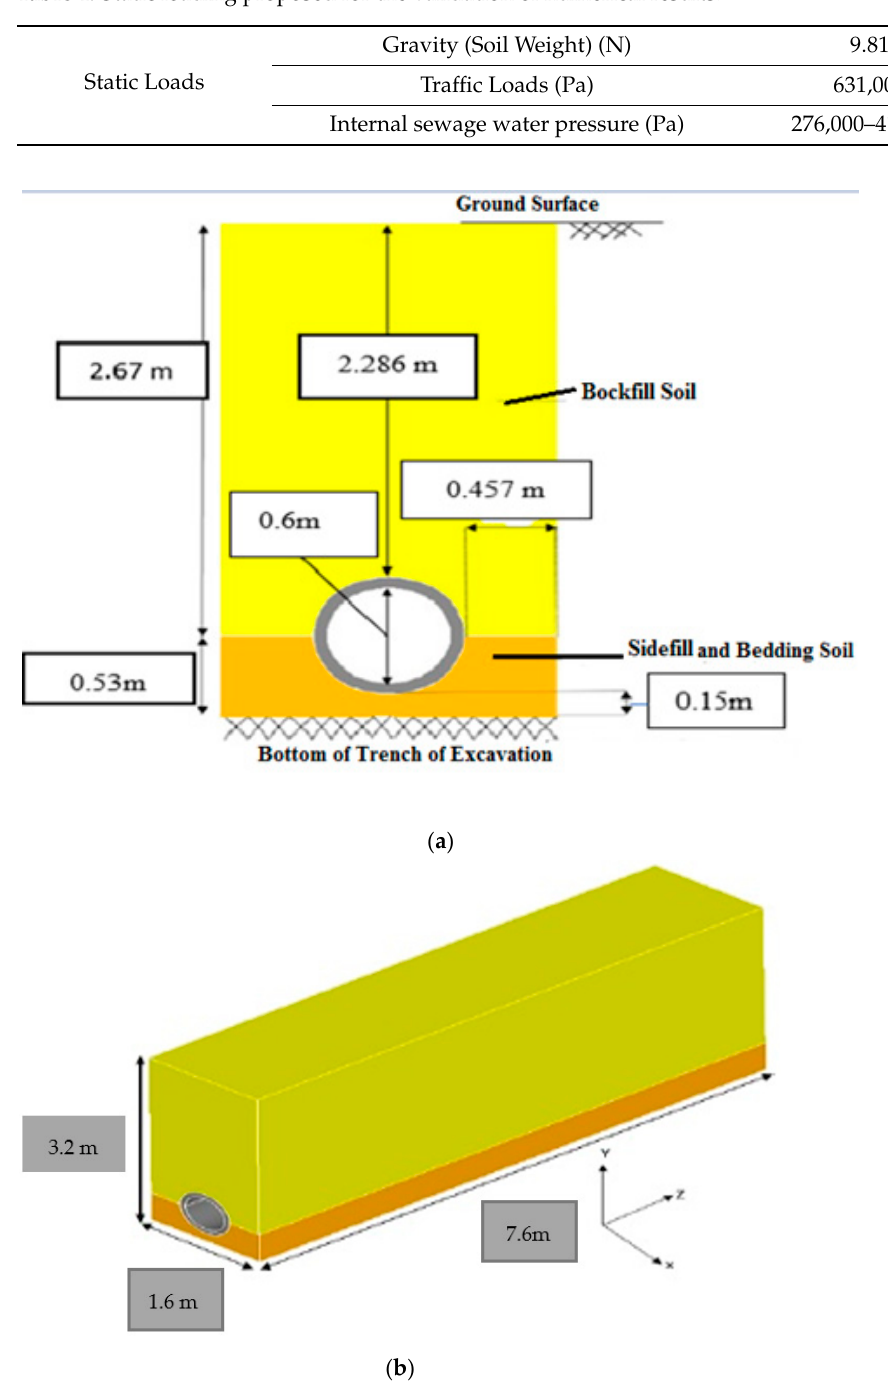
Figure 4. ( a ) 2D and ( b ) 3D original pipe models in ANSYS based on Zamarian [28].